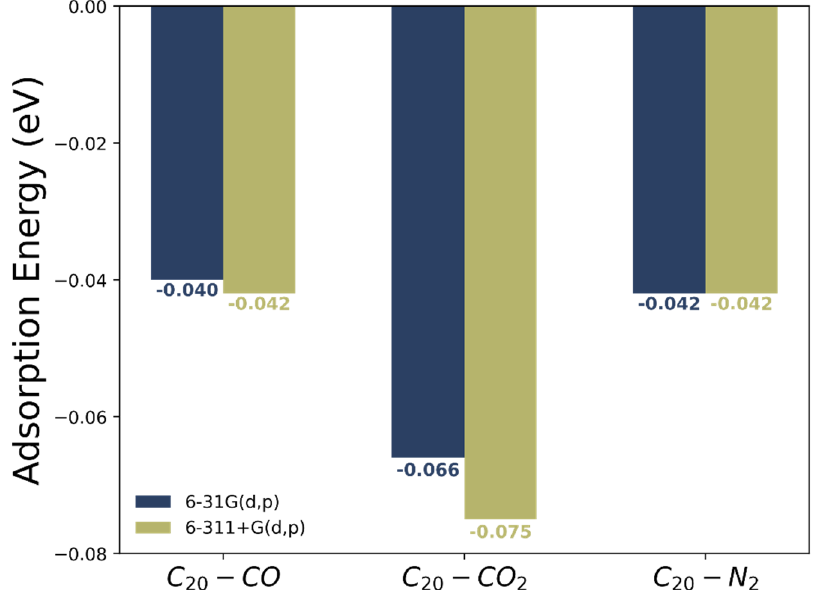
Figure 3. Adsorption energies (in eV), E ads , for the dimers formed between C 20 fullerenes with CO, CO 2 and N 2 molecules calculated with the theoretical levels ω B97XD/6-31G(d) and ω B97XD/6- 311+G(d,p).